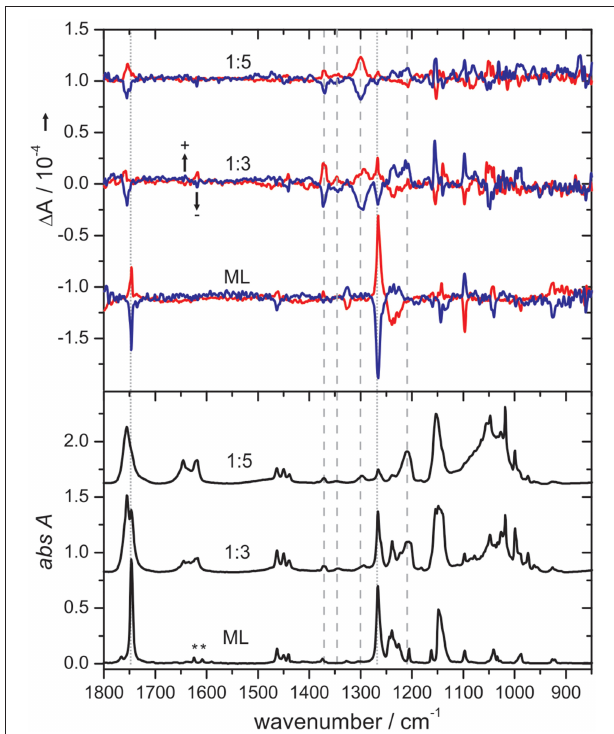
FIGURE 9 | Comparison of IR and VCD spectra of pure ML (obtained at 10 K) with those obtained for the 1:3 and 1:5 ML/NH 3 mixtures at 30 K in cold Ar matrices. The bands of residual water in the matrix are marked with an asterisk. The dotted and dashed lines indicate characteristic bands of the ML monomer and the ML-NH 3 complex, respectively, whose intensities change with the sample composition. Reproduced with permission from Merten and Xu (2013c). Copyright 2013, Wiley-VCH Verlag GmbH & Co. KGaA, Weinheim.